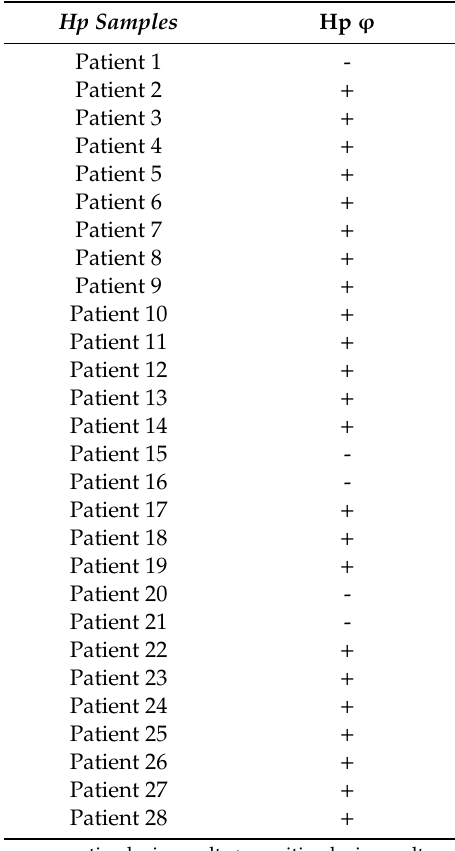
Table 1. Phage host range determination on di ff erent samples from the gastroenterology department of “Ospedale Evangelico Villa Betania”